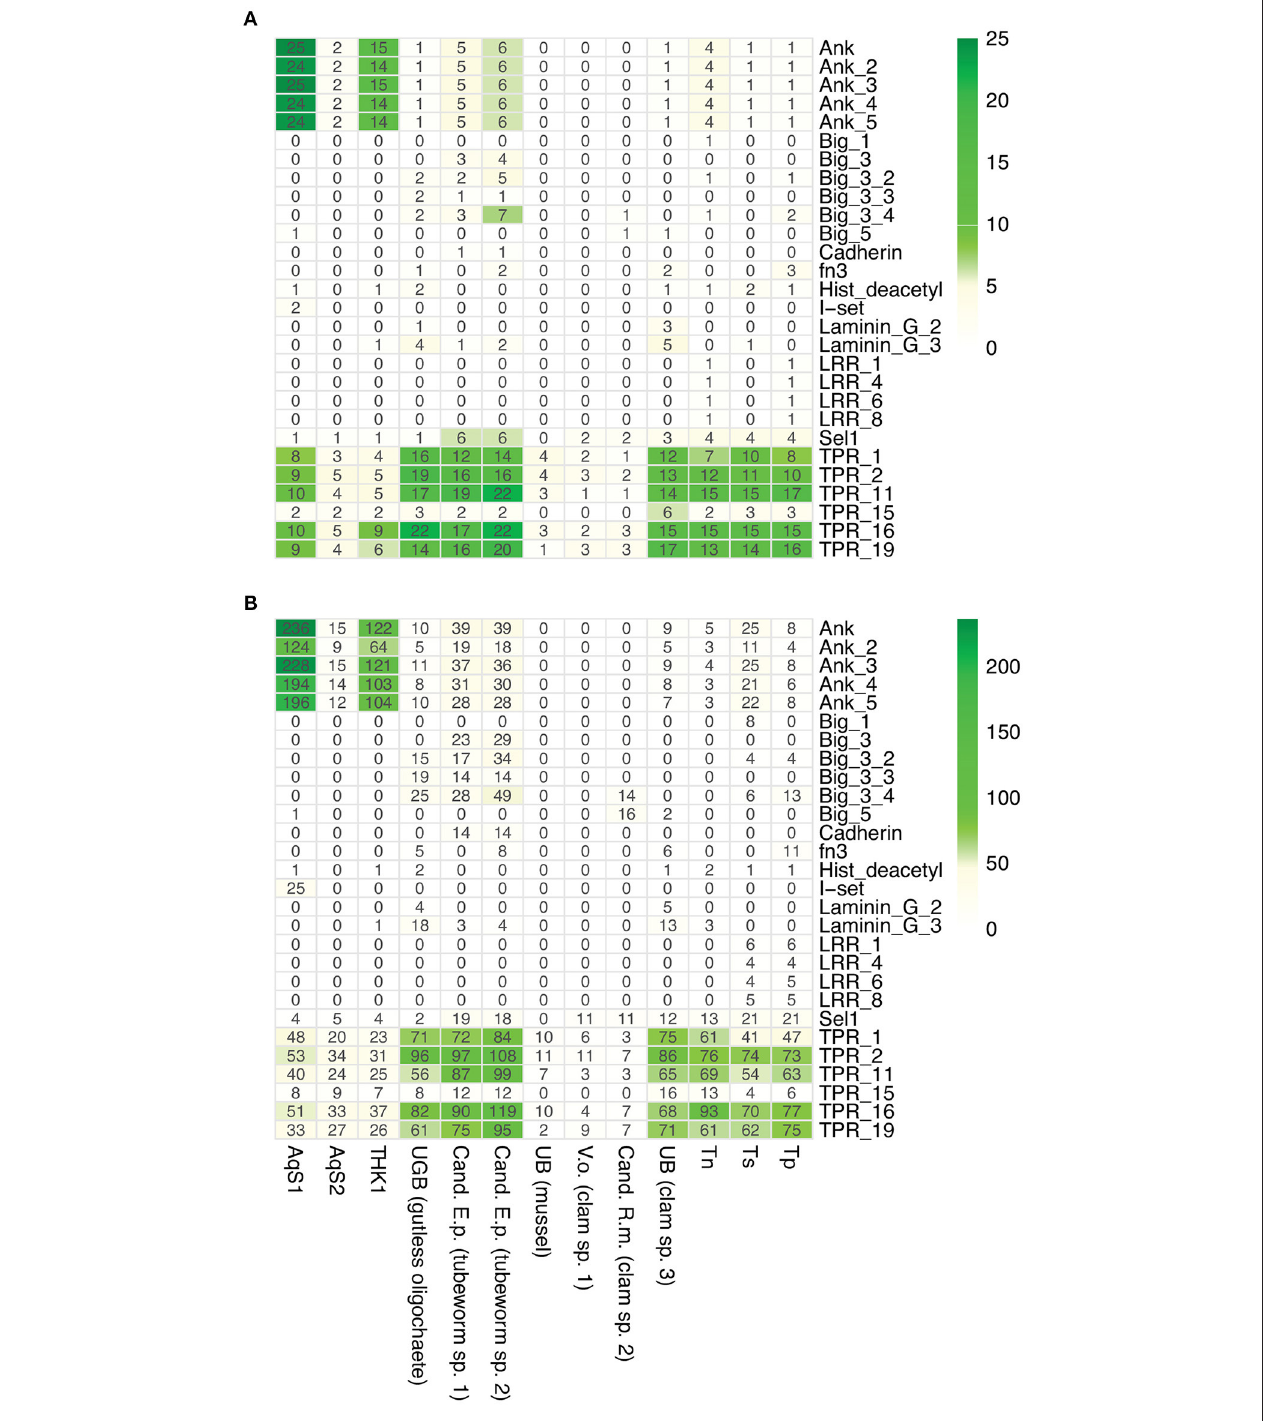
FIGURE 7 | Occurrence of eukaryotic-like containing proteins in AqS1 and AqS2 . (A) Counts of eukaryotic-like containing proteins. (B) Counts of eukaryotic domains. THK1 Thioalkalivibrio sp. HK1; UGB (gutless oligochaete ) Gamma3 isolated from Olavius algarvensis JGI genome accession number 2004178004; Cand. E.p. (tubeworm sp. 1) Candidatus Endoriftia persephone isolated from Riftia pachyptila , accession number AFOC00000000; Cand. E.p. (tubeworm sp. 2) Candidatus E. persephone isolated from Tevnia jerichonana , accession number AFZB00000000; UB (mussel) Unknown thiotroph isolated from Bathymodiolus sp., accession number CAEB01000001; V.o. (clam sp. 1) Candidatus Vesicomyosocius okutanii isolated from Calyptogena okutanii , accession number NC_009465.1; Cand. R.m. (clam sp. 2) Candidatus Ruthia magnifica isolated from Calyptogena magnifica , accession number NC_008610.1; UB (clam sp. 3) Unknown symbiont isolated from Solemya velum , accession number NZ_JRAA00000000.1; Tn Thioalkalivibrio nitroreducens; Ts Thioalkalivibrio sulfidophilus HL-EbGr7 ; Tp Thioalkalivibrio paradoxus ARh 1